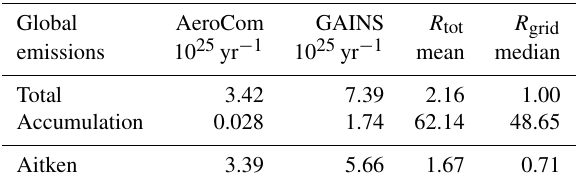
Table 3. Annual total anthropogenic particle number emissions (second and third columns) and respective global average ratios (fourth and fifth columns) computed for the whole domain. R tot ratios are calculated by firstly averaging the emissions among the whole domain for each data set and secondly by dividing GAINS by AeroCom. This method aims at studying absolute differences in the global emissions with no regard to geographical distribution differ- ences. In R grid we firstly divide the data sets to keep the information of data set differences for each grid cell and secondly compute the median of gridded ratios. R grid is weighted by surface area of the grid cell.